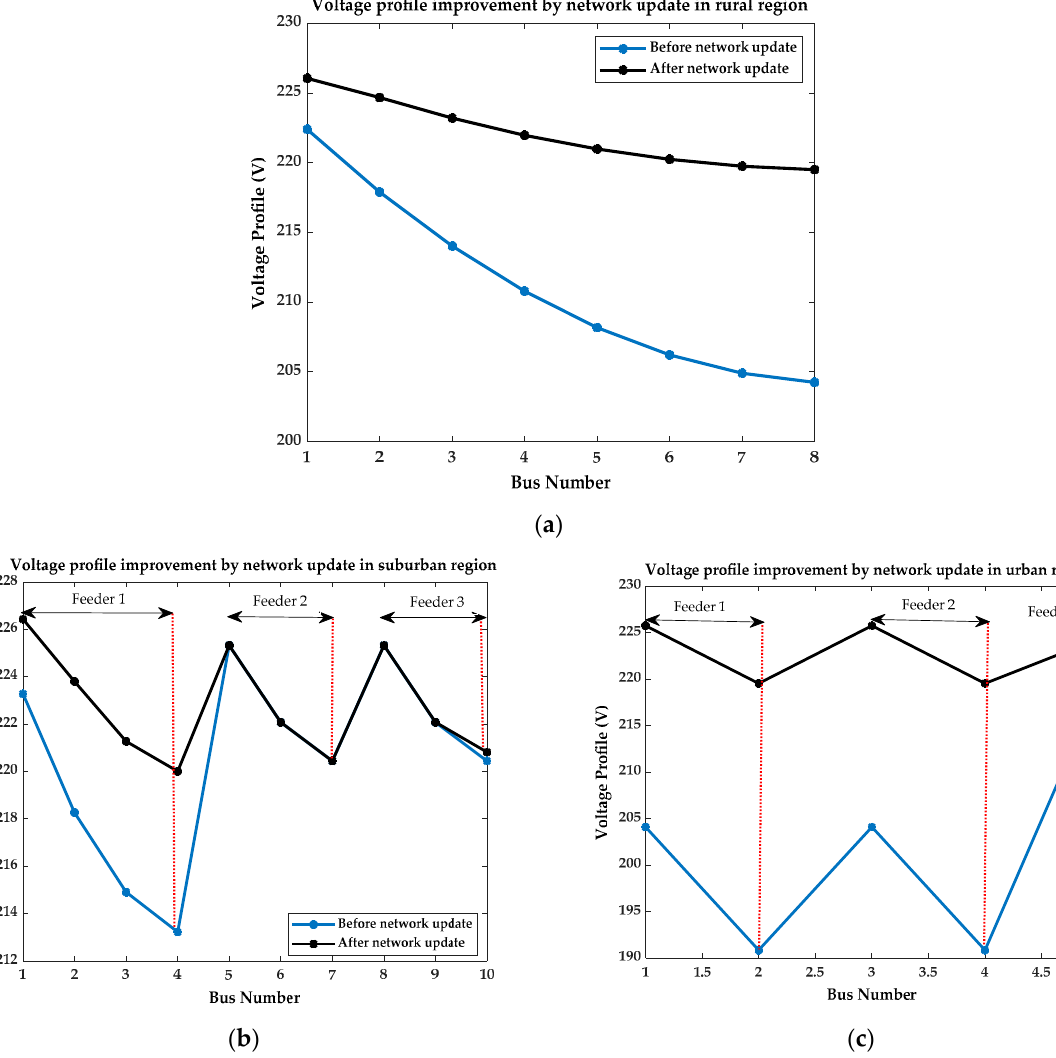
Figure 6. The voltage profile improvement by optimal network formation for three regions: ( a ) Rural; ( b ) suburban; ( c ) urban. Table 6. Final cables selection for the three regions satisfying the technical and cost